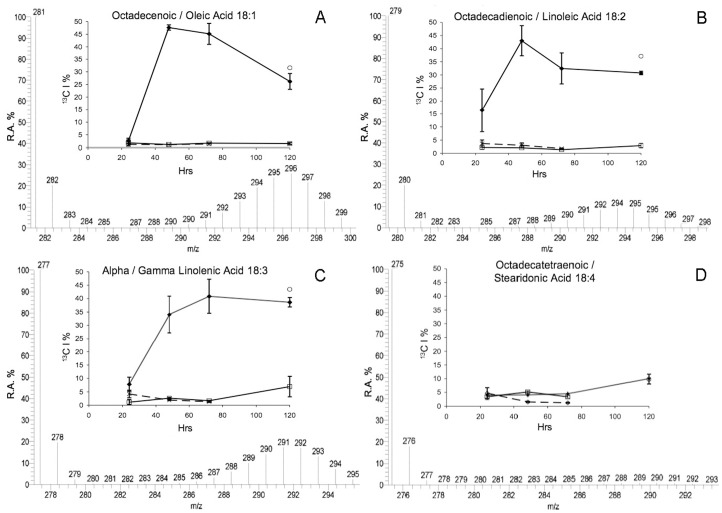
See
Figure 2
 legend.